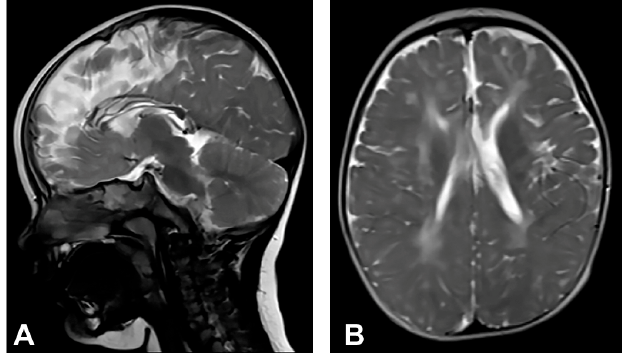
Figure 2. (Case 2) ( A ) Sagittal T2W magnetic resonance image at the age of one shows CC hypoplasia especially of the rostrum and body. ( B ) Axial T2W magnetic resonance image shows brain atrophy, supratentorial white matter reduction with elevated IS on T2W/FLAIR and gliotic changes. Mild bilateral non-progressive ventriculomegaly is more prominent on the left.